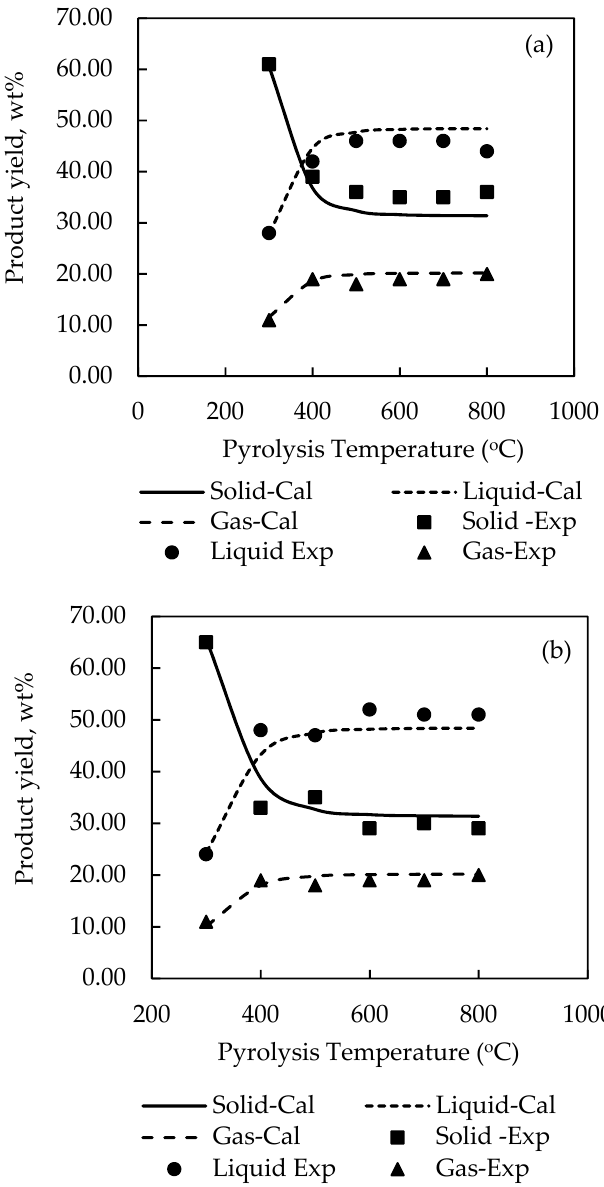
Figure 6. Comparison of experimental and calculated pyrolysis yields for ( a ) palm shell and ( b ) coconut shell by using pyrolysis reaction model G01.